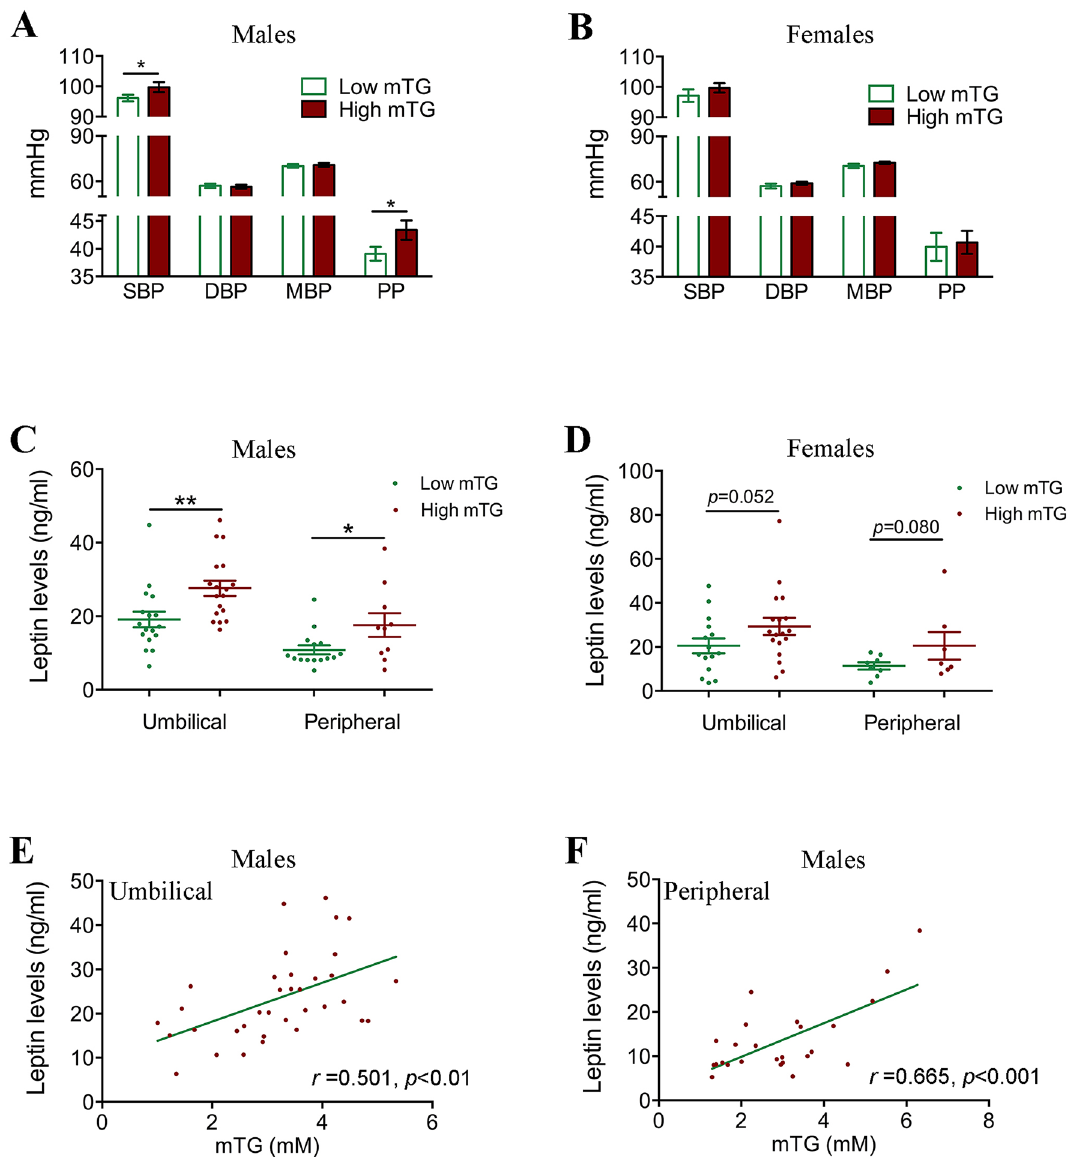
Figure 5. High maternal triglyceride (mTG) levels are associated with elevated blood pressure and leptin levels in offspring. ( A ) Blood pressures in male offspring of preschool-age children in the low- (n = 37) and high- (n = 36) mTG-level exposure groups. ( B ) Blood pressures in female offspring of preschool-age children in the low- (n = 22) and high- (n = 26) mTG-level exposure groups. ( C ) Serum leptin levels in male newborns and preschool-age children from low- (n = 17 and 15 for newborns and preschool-age children, respectively) and high- (n = 18 and 10 for newborns and preschool-age children, respectively) mTG-level mothers. ( D ) Serum leptin levels in female newborns and preschool-age children from low- (n = 1 5 and 8 for newborns and preschool-age children, respectively) and high- (n = 18 and 7 for newborns and preschool-age children, respectively) mTG-level mothers. ( E ) Correlation between serum leptin levels in cord blood from male offspring and mTG levels (n = 35). ( F ) Correlation between male preschool-age children’s serum leptin levels and mTG levels (n = from fetuses subcutaneously within 24 h of birth and embedded in paraffin or processed for RNA, DNA or protein extraction as described below. Wire myograph and the measurement of vascular responses. The experiment was performed in one-year-old male offspring. Small-vessel myography was performed as previously described in detail 34 . In brief, after one-year-old rat offspring were sacrificed by decapitation, mesenteric arteries (third-order branch of the superior mesenteric artery) were isolated and cut into 2 mm rings in ice-cold PBS solution and mounted on a Mulvany-Halpern wire myograph (model 620 M, Danish Myo Technology, Aarhus, Denmark). Following